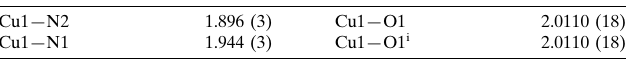
Selected bond lengths (A˚ ).